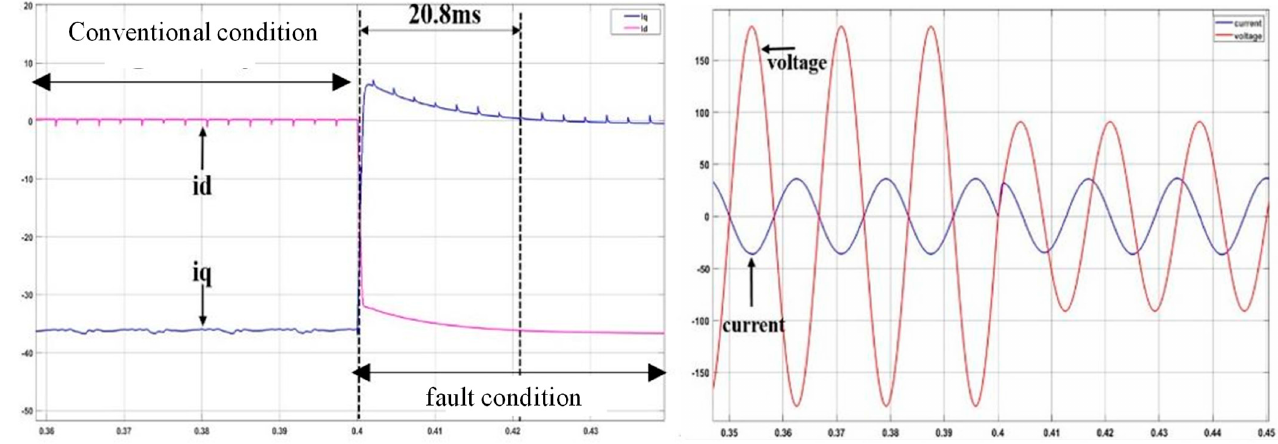
Figure 28. Phase voltage, current, and reactive current response results for independent operation depending on grid voltages.